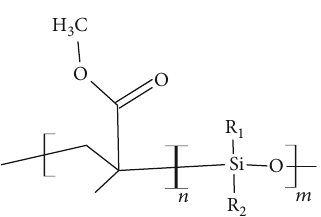
Figure 12: Siloxane-poly(methyl methacrylate)